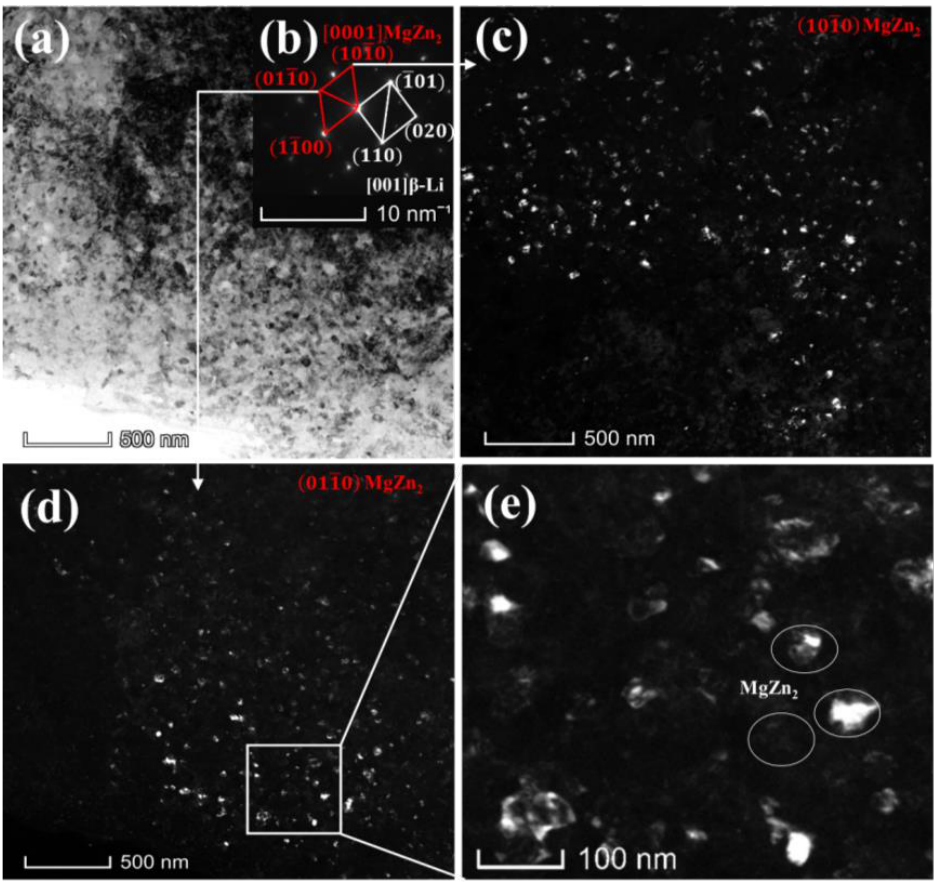
Figure 2. ( a , b ) Fine grains in bright-field TEM images of cryogenic MD-rolled alloy; ( c ) diffraction spot image.